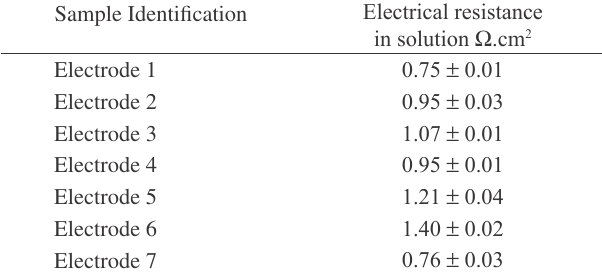
Table 2. Electrical resistance of composite electrodes in 1M NaOH solu- tion.